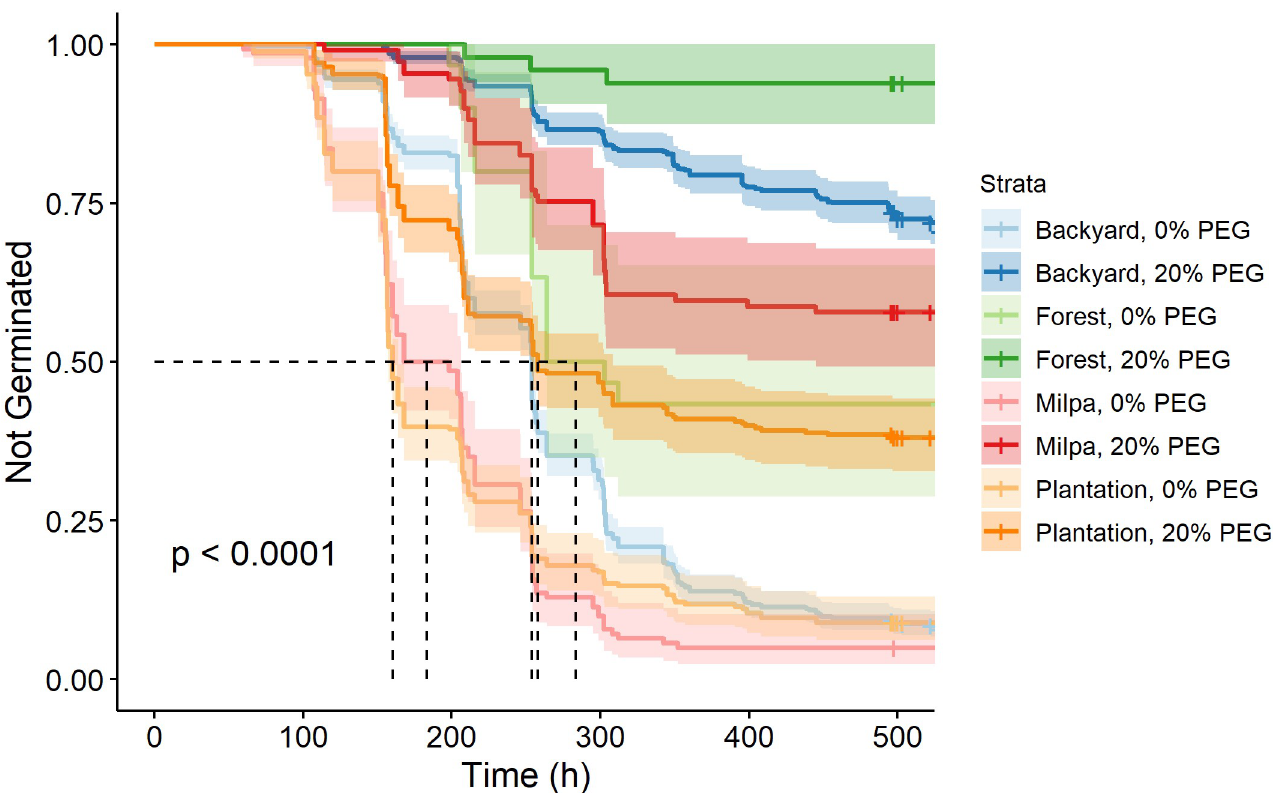
Fig 6. Kaplan-Meier estimates of survivor functions (and their 95% confidence intervals) for chile pepper accessions originating from the Eastern Coast of Oaxaca, Mexico according to cultivation system of origin. The p-value from a log-rank test compares survival distributions. The dotted line represents the time to 50% germination (t 50 ). Pairwise comparisons of individual curves are presented in Table 10 in S3 File.